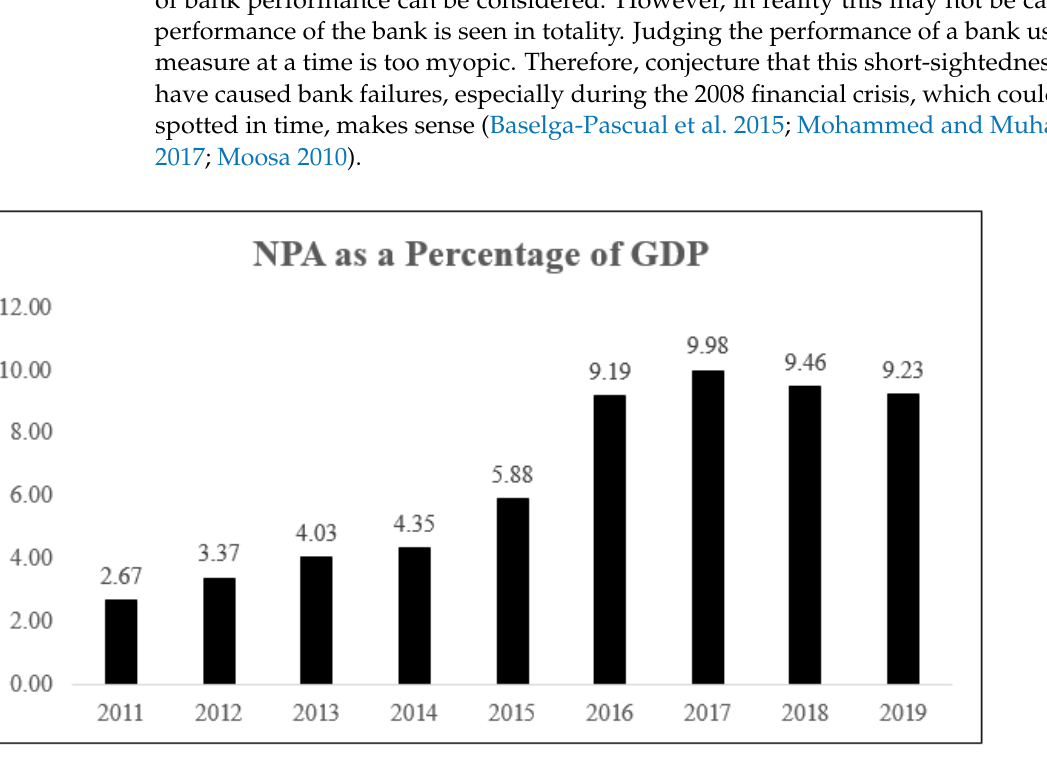
Figure 1. Level of NPAs as a percentage of GDP in India. Source: Data is taken from the official website of World Bank (https://data.worldbank.org/indicator/FB.AST.NPER.ZS?end=2019&locations=IN&start=2008&view=chart; accessed on February 2021).